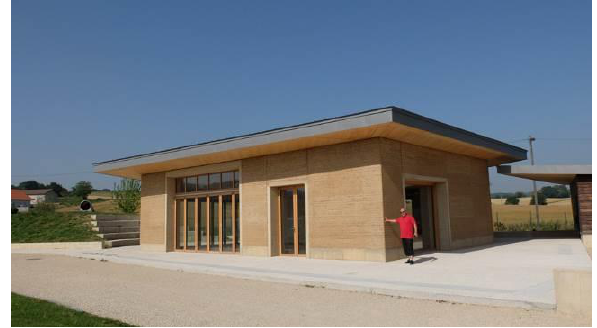
Figure 4. Maison pour Tous in Four, France © CRAterre_Moriset 2019.